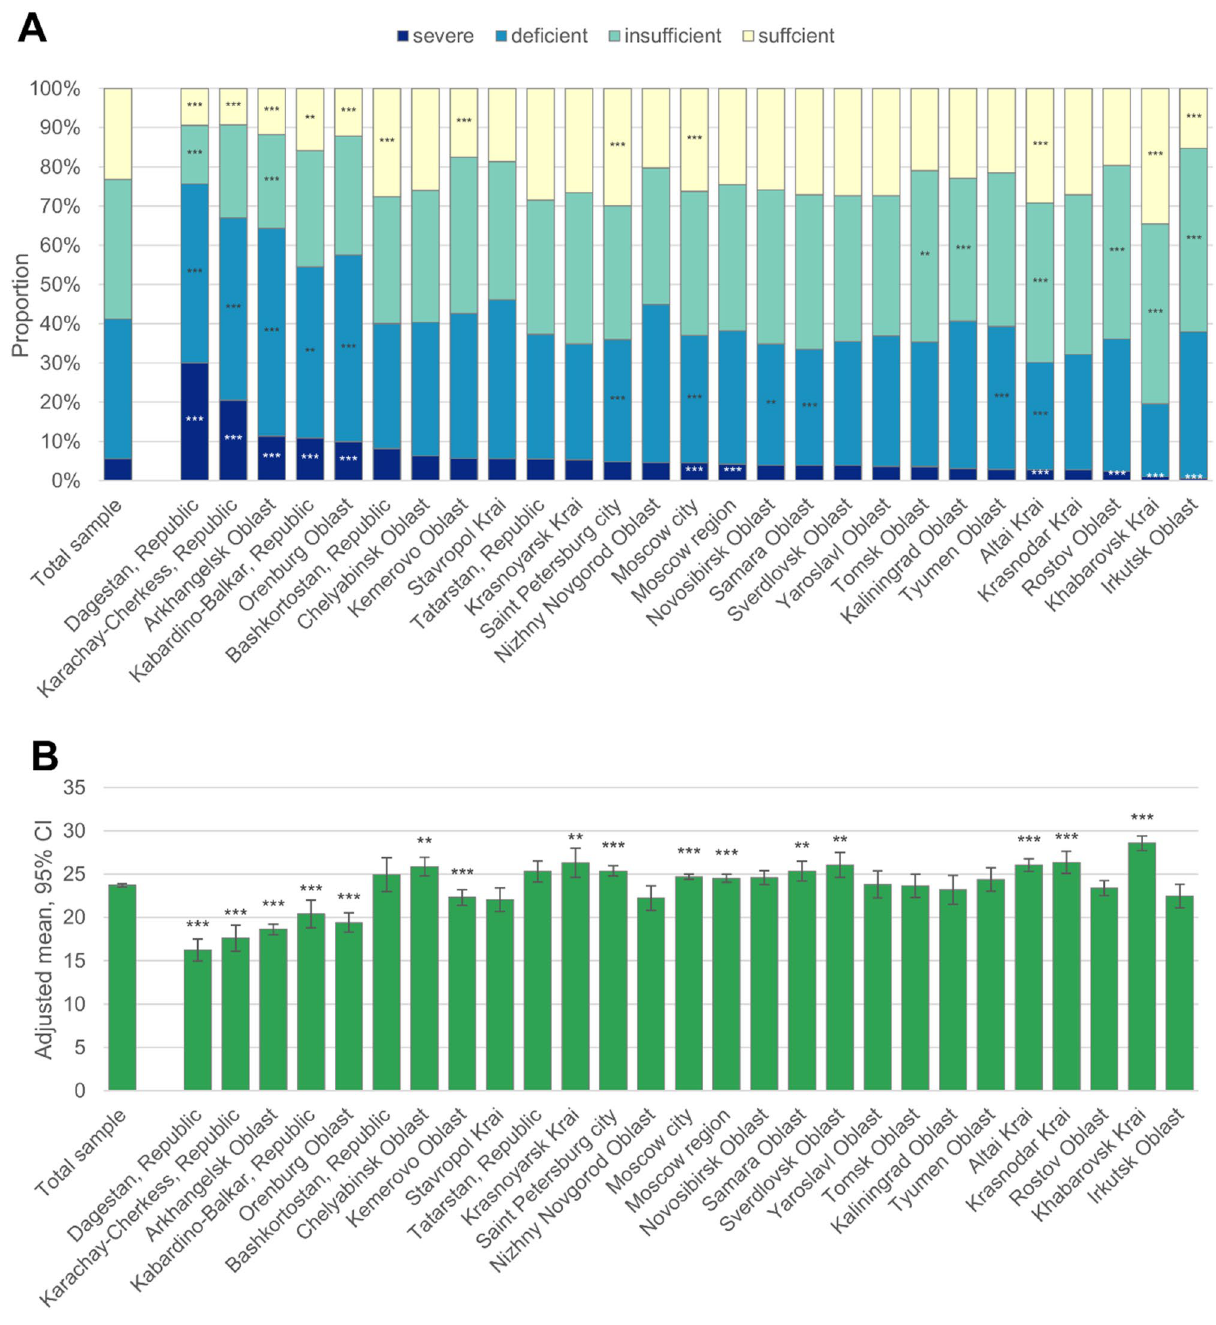
Figure 2. Adjusted proportion with severe, deficient, insufficient and sufficient ( B ) 25(OH)D concentrations and adjusted mean 25(OH)D concentrations ( A ) and by region. Values are fixed at the average level for the population apart from sex, which was weighted to represent the Russian population (53.7% female). Data are from 2013 to 2018 and are from all months of the year. Asterisks indicate p-value compared to total sample: *** p < 0.001; ** 0.001 < p <